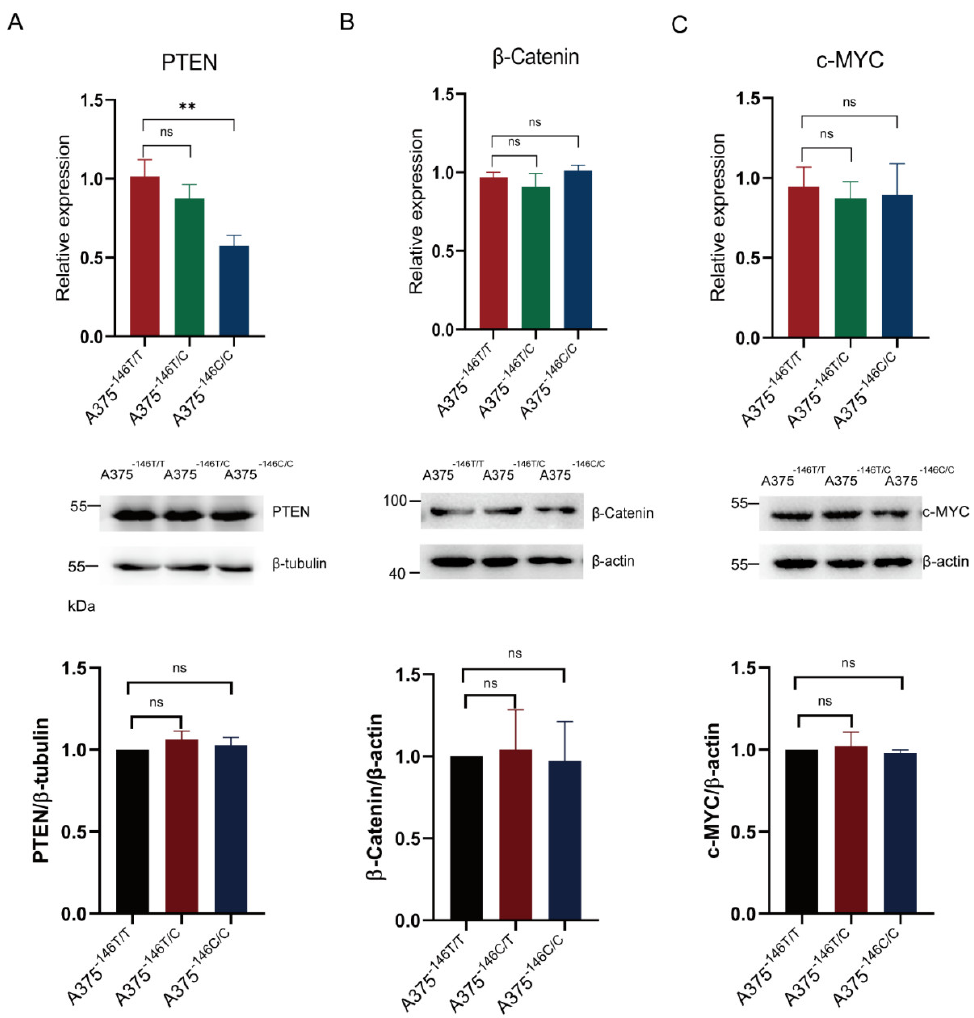
Figure 5. The TERT promoter revertant mutation and Wnt/β-Catenin signaling. ( A ) PTEN transcription expression and gray value analysis in A375 -146T/T and cells with TERT promoter revertant mutations; ( B ) β-Catenin transcription expression and gray value analysis in A375 -146T/T and cells with TERT promoter revertant mutations; ( C ) c-MYC transcription expression and gray value analysis in A375 -146T/T and cells with TERT promoter revertant mutations. Student’s t -test. ** p < 0.01.